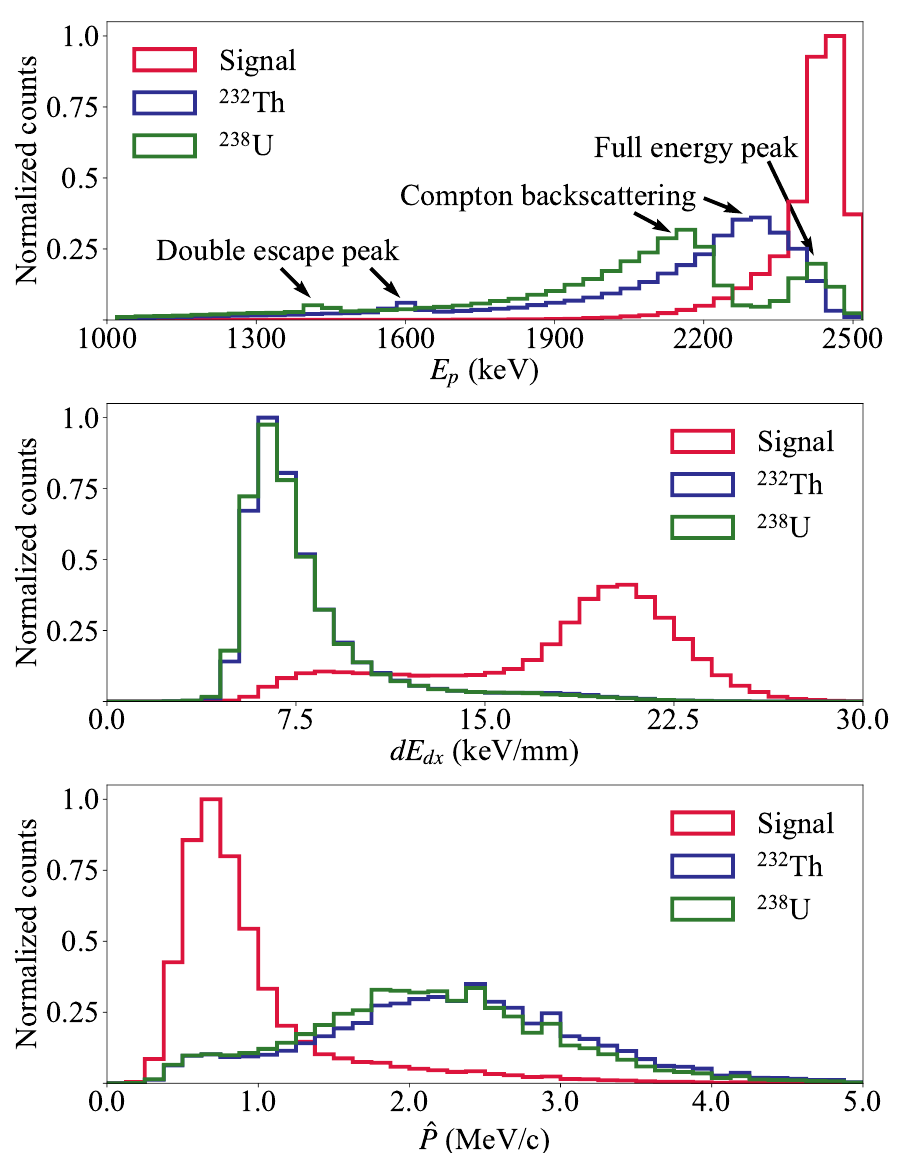
Figure 5. Distributions of the three parameters from the principal track though the KFB workflow, including E p , dE dx , and ˆ P , for the (1 mm, 3%) configuration. E p represents the total deposited energy of the principal track. In the E p distribution of background, double escape peaks, Compton backscattering peaks, and a full absorption peak at 2447 keV are visible and marked. dE dx represents the energy loss per unit travel length. The statistical length is 21 mm. ˆ P represents the momenta at the ends of the reconstructed track. The Y axis is normalized by the highest value in each